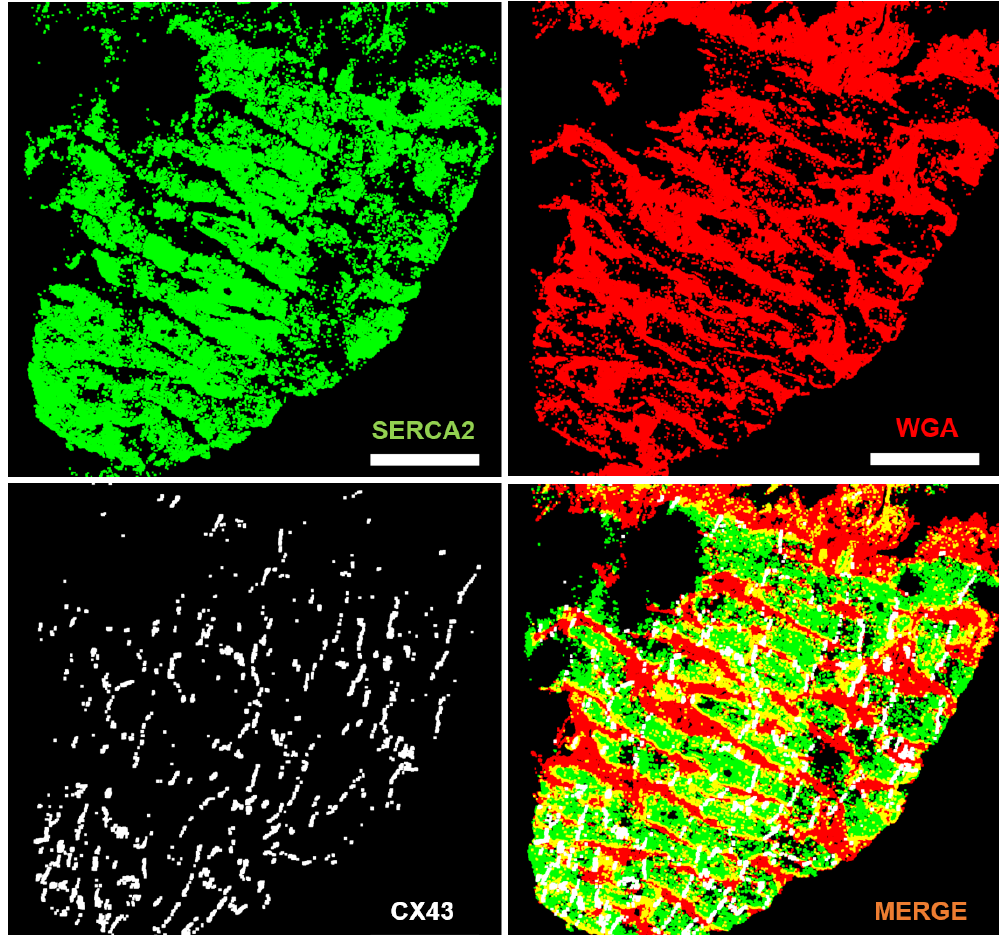
Figure 4. Top: M c 1 (SERCA2) and M c 3 (WGA) binarized channels. Bottom left: M c 2 (CX43) binarized channel. Bottom right: merged channel. Scale bar = 100 µ